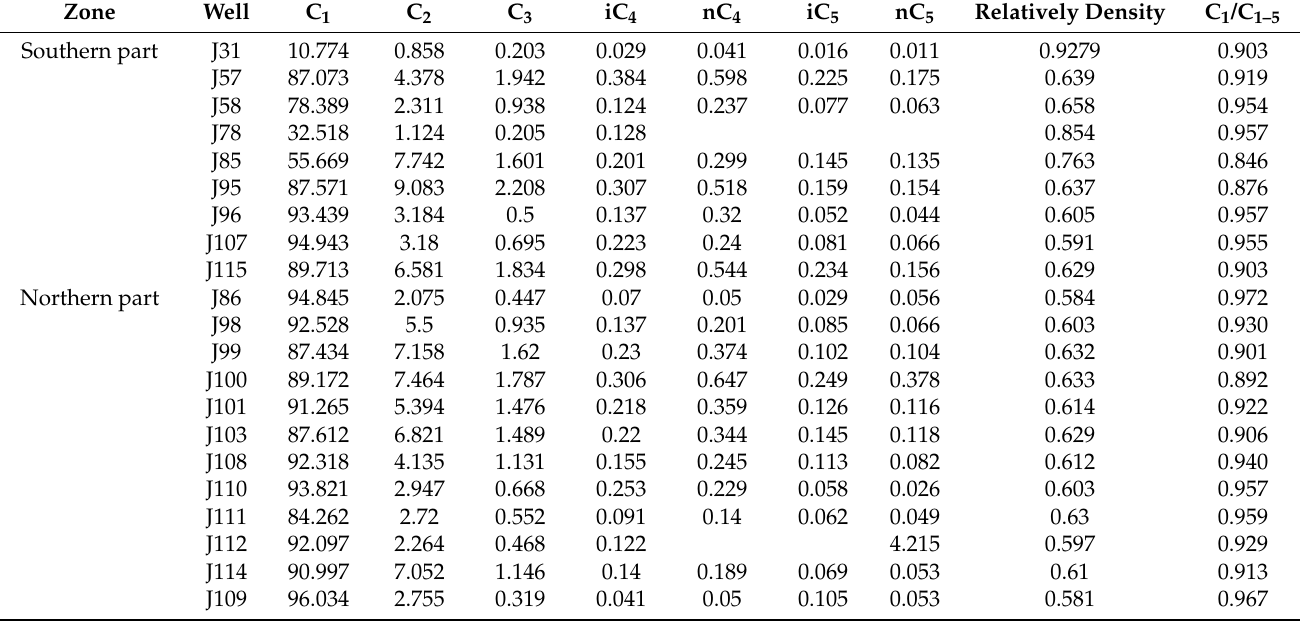
Table 5. Hydrocarbon composition of Lower Shihezi Formation tight gas in the Duguijiahan block.